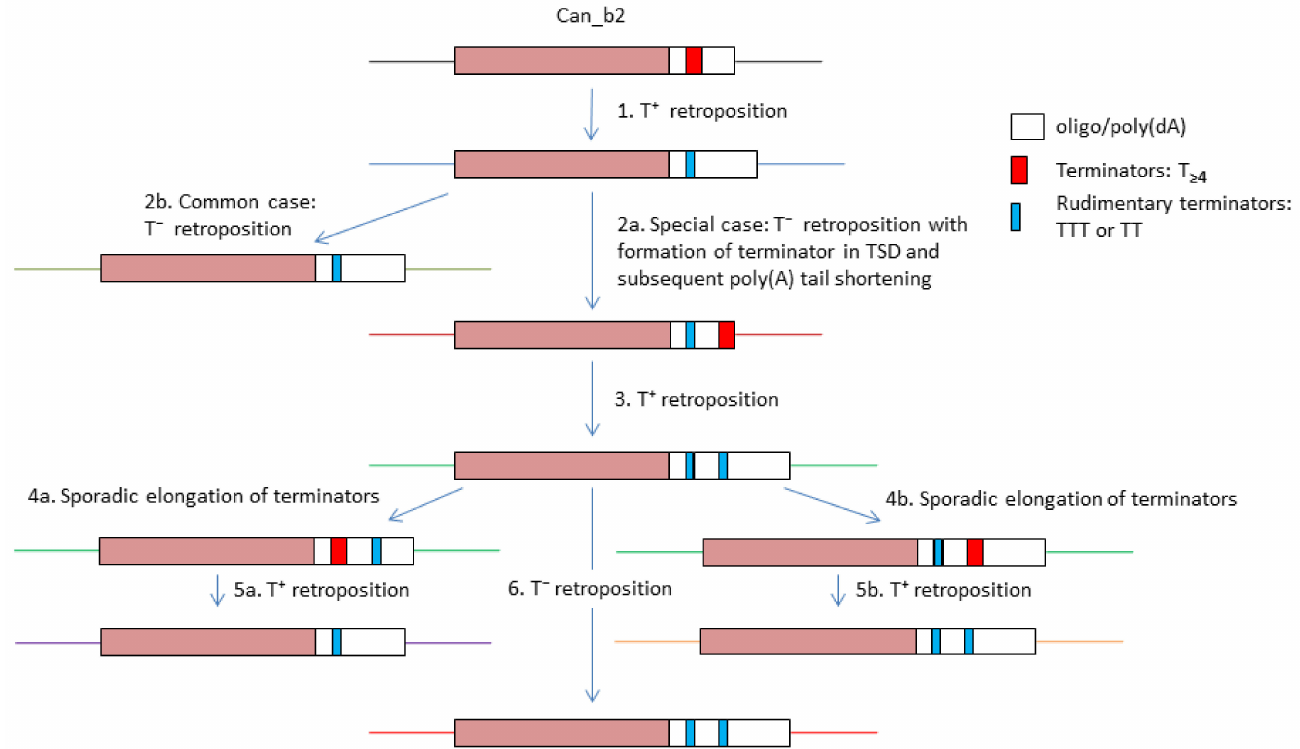
Figure 8. Schematic illustration of the multiplicity of 3 (cid:48) -terminal parts of Can_b2 (tribe 2 copies) and putative underlying mechanisms. SINEs with A-tails and terminators are given as boxes. The same flanking loci are indicated by same colors. See text for other